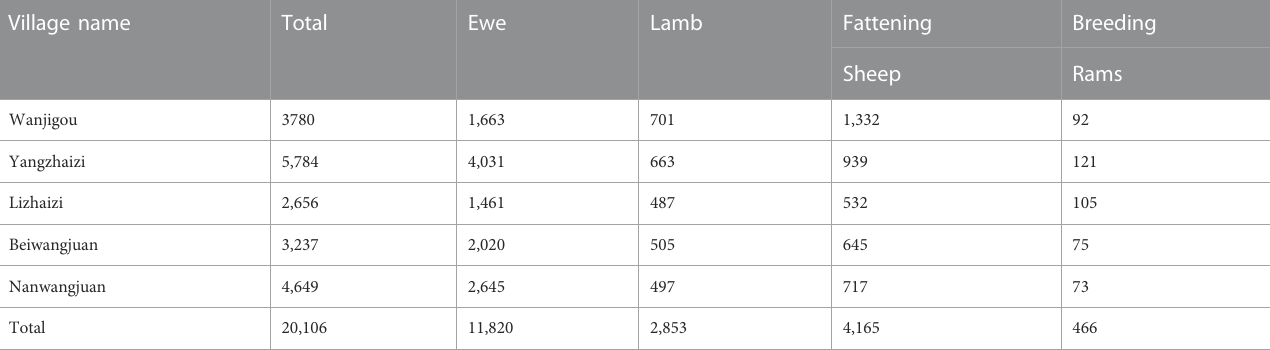
TABLE 3 Statistics of the current situation of sheep breeding in fi ve villages administered by Wanjigou villages and analyzed. Village